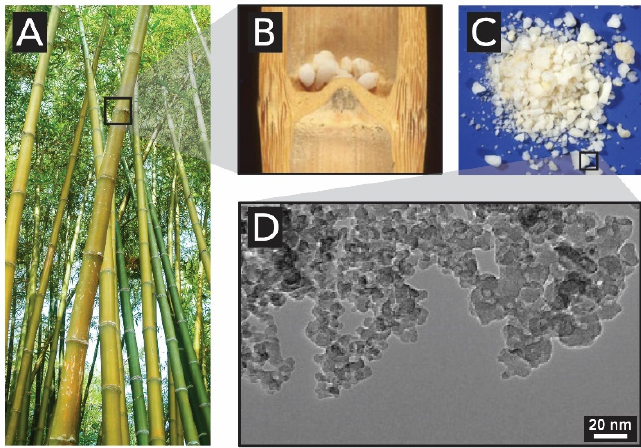
Figure 18. Bamboo plants and their silica content. ( A ) Bamboo tree forest. ( B ) Close look on tabashir granulae inside the pit cavity of old culms. ( C ) Image of tabashir particles collected from old culms. ( D ) TEM image of biogenic hydrated SiO 2 particles. Images A–C are reproduced from [126] with permission from Springer Nature. Image D is adapted from [127] with permission from